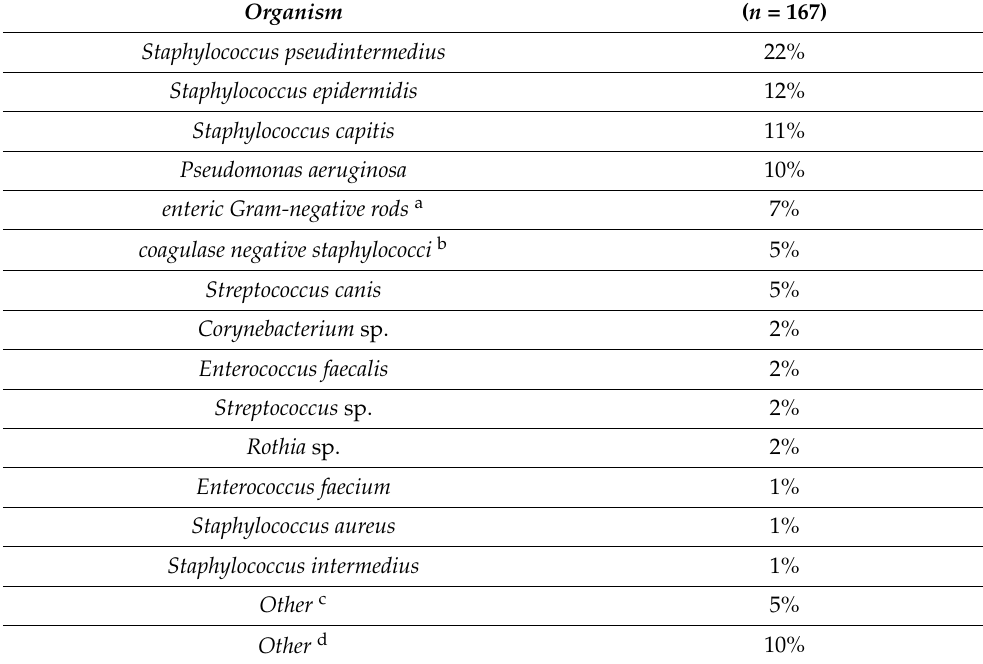
Table 1. Bacterial species distribution from corneal stromal ulcer samples. Distribution of incidence of the specific microorganism detection in canine patients. Data are presented as a percentage of total isolates ( n = 167). a Citrobacter freundii , Enterobacter cloacae , Escherichia coli , and Serratia marcescens ; b Staphylococcus spp. ( S. auricularis , S. hominis , S. saprophyticus , S. simulans , S. warneri , and S. xylosus ) excluding S. pseudintermedius , S. capitis , S. epidermidis , Staphylococcus intermedius and S. aureus. c Gram- positive and Gram-negative bacteria (this group was identified by Gram labeling since MALDI-TOF analysis yielded no identification) and unknown (this group was also not identified by MALDI-TOF analysis). These two groups likely represent multiple bacterial species on the target plate spot or no hit in the MALDI-TOF data base. d Presence of each isolate of 1% or less represented by Acinetobacter johnsonii , Actinomyces sp., Bacillus pumilus , Bacillus sp., Exiguobacterium sp.,